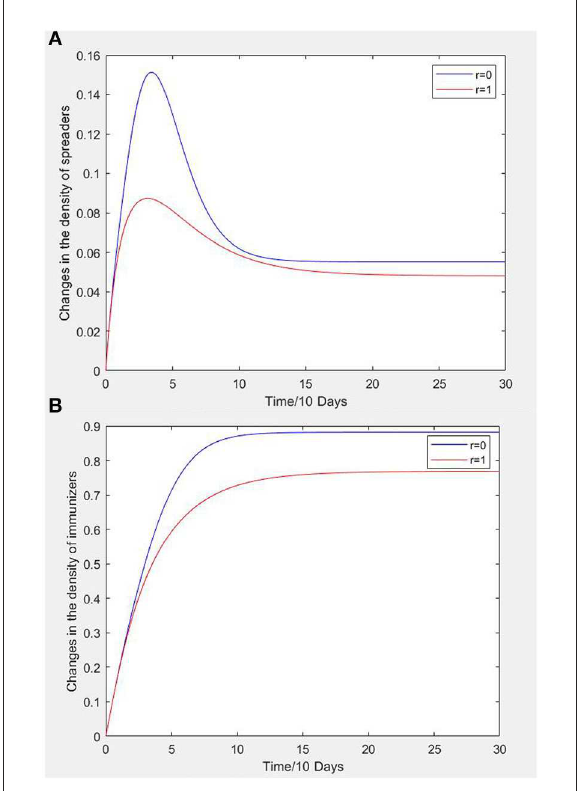
FIGURE4 (A) Effect of the presence or absence of intimacy on changes in infectors density. (B) Effect of the presence or absence of intimacy on changes in recovered persons